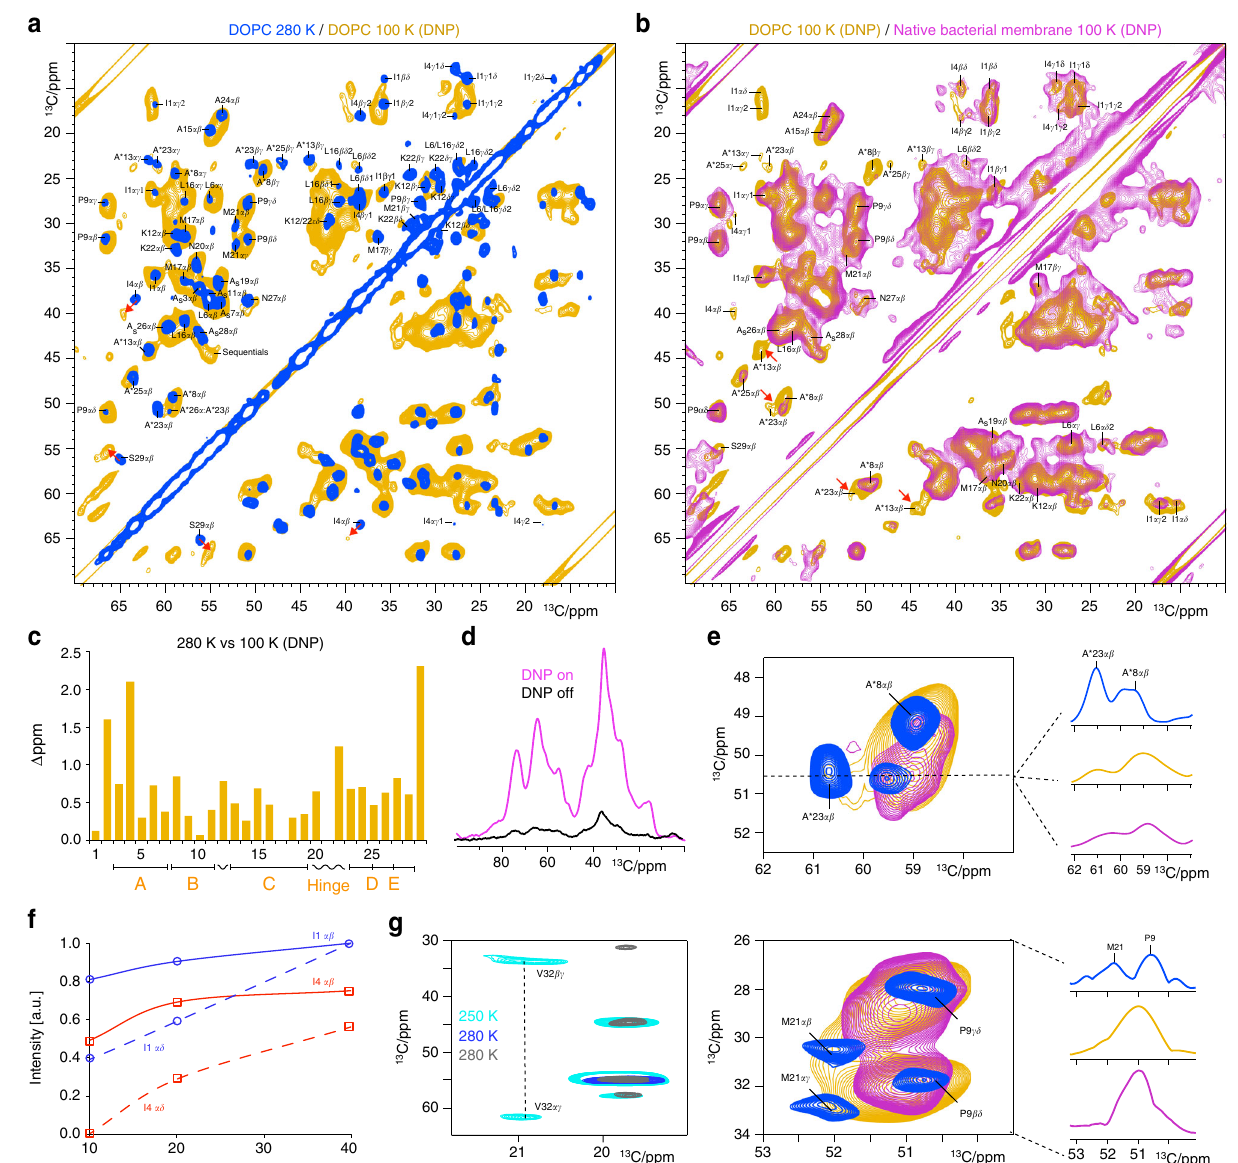
Fig. 3 DNP-enhanced ssNMR on the lipid II-bound state of nisin in the pore. a 2D 13 C – 13 C ssNMR spin diffusion spectra of the lipid II-bound state of nisin in the pore in DOPC acquired at 280 K sample temperature (blue) and at 100 K with DNP enhancement (orange). Red arrows highlight strong CSPs. b Overlay of DNP-ssNMR 2D 13 C – 13 C spectra of nisin in the pore acquired in DOPC (orange) and in cellular M. fl avus vesicles (magenta). Both spectra were acquired at identical conditions using 10.6 kHz MAS, 800MHz and 40 ms 13 C – 13 C mixing. c Combined (C α + C β ) CSPs comparing lipid II-bound nisin in DOPC at 280 K against 100 K temperature (DNP conditions). d 13 C cross-polarization spectra of lipid II-bound nisin in M. fl avus vesicles with (magenta) and without (black) DNP enhancement. e The hinge domain is conformationally fl exible and broadens out at DNP conditions in DOPC (orange). This is even more pronounced in cellular membranes (magenta). Upper panel: (left) zoom into A*23 adjacent to the hinge; (right) slice through the A*23 αβ signal. Lower panel: (left) zoom into M21; (right) projection along the indirect dimension (26 – 34 13 C ppm). f 13 C – 13 C PDSD spin diffusion buildup curves of the C αβ (continuous lines) and C αδ (dashed lines) cross-peaks for residues I1 (in blue) and I4 (red). g The mobile nisin C terminus gives faint signals in dipolar 2D 13 C – 13 C spectra at 280 K (in gray and dark blue with 100 ms and 30 ms 13 C – 13 C mixing, respectively), while stronger signals appear at 250 K (in cyan, 50 ms